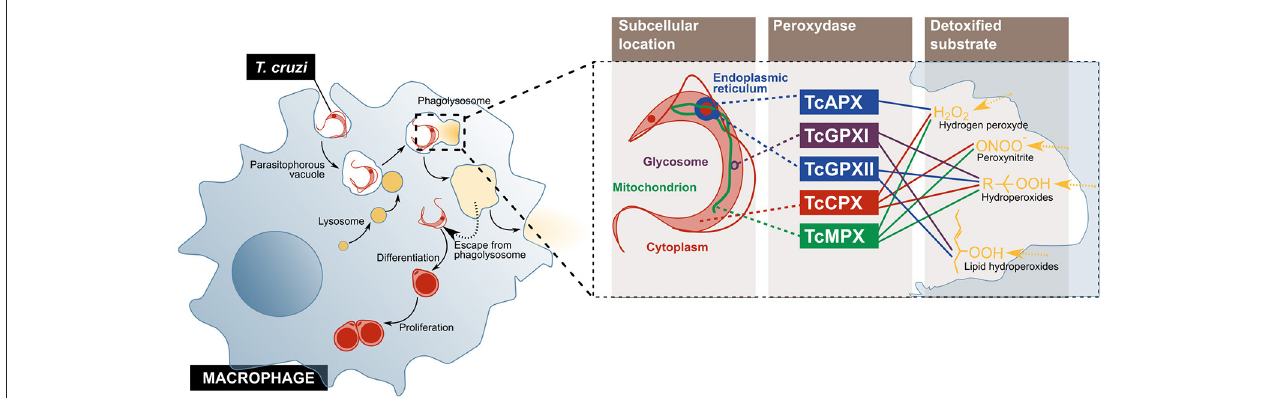
FIGURE 2 | T. cruzi evades the microbicidal action of the macrophage by escaping from the phagolysosome into the cytoplasm, and by using enzymes that detoxify oxygen and nitrogen reactive species. The parasite enters the cell and escapes from the normal phagolysosome pathway, before its differentiation, and replication (Left) . On the (Right) , the peroxidases used by the parasite to inactivate different components of the oxidative burst imposed by activated macrophage are represented. TcCPX, T. cruzi cytosolic tryparedoxin peroxidases; TcMPX, T. cruzi mitochondrial tryparedoxin peroxidases; TcAPX, T. cruzi ascorbate-dependent haemoperoxidase; TcGPXI, T. cruzi glutathione peroxidases I; TcGPXII, T. cruzi glutathione peroxidases II.